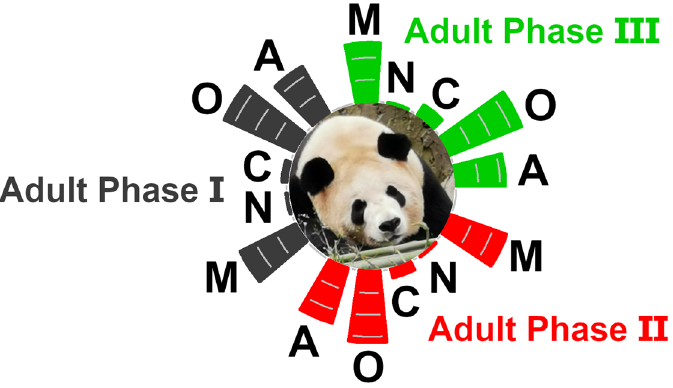
Figure 2. Relative abundances of the classes of molecules assigned in the giant panda seminal plasma metabolome. As a reference, the lines inside the bars highlight 10% steps. C = carbohydrates and derivatives, O = organic acids and derivatives, A = amino acids, peptides, and derivatives, N = nucleosides, nucleotides, and analogues, M = miscellaneous, as suggested in the reports by Zhu et al. [23].